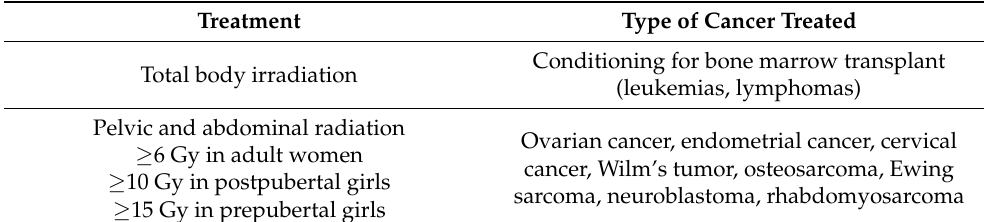
Table 2. Treatments considered to carry a high risk of radiotherapy related infertility or infertility- related outcome in women (>80%)